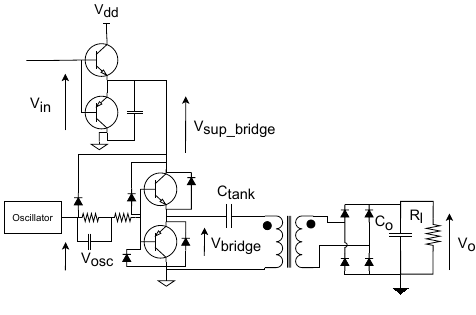
Figure 3. Analog Isolator